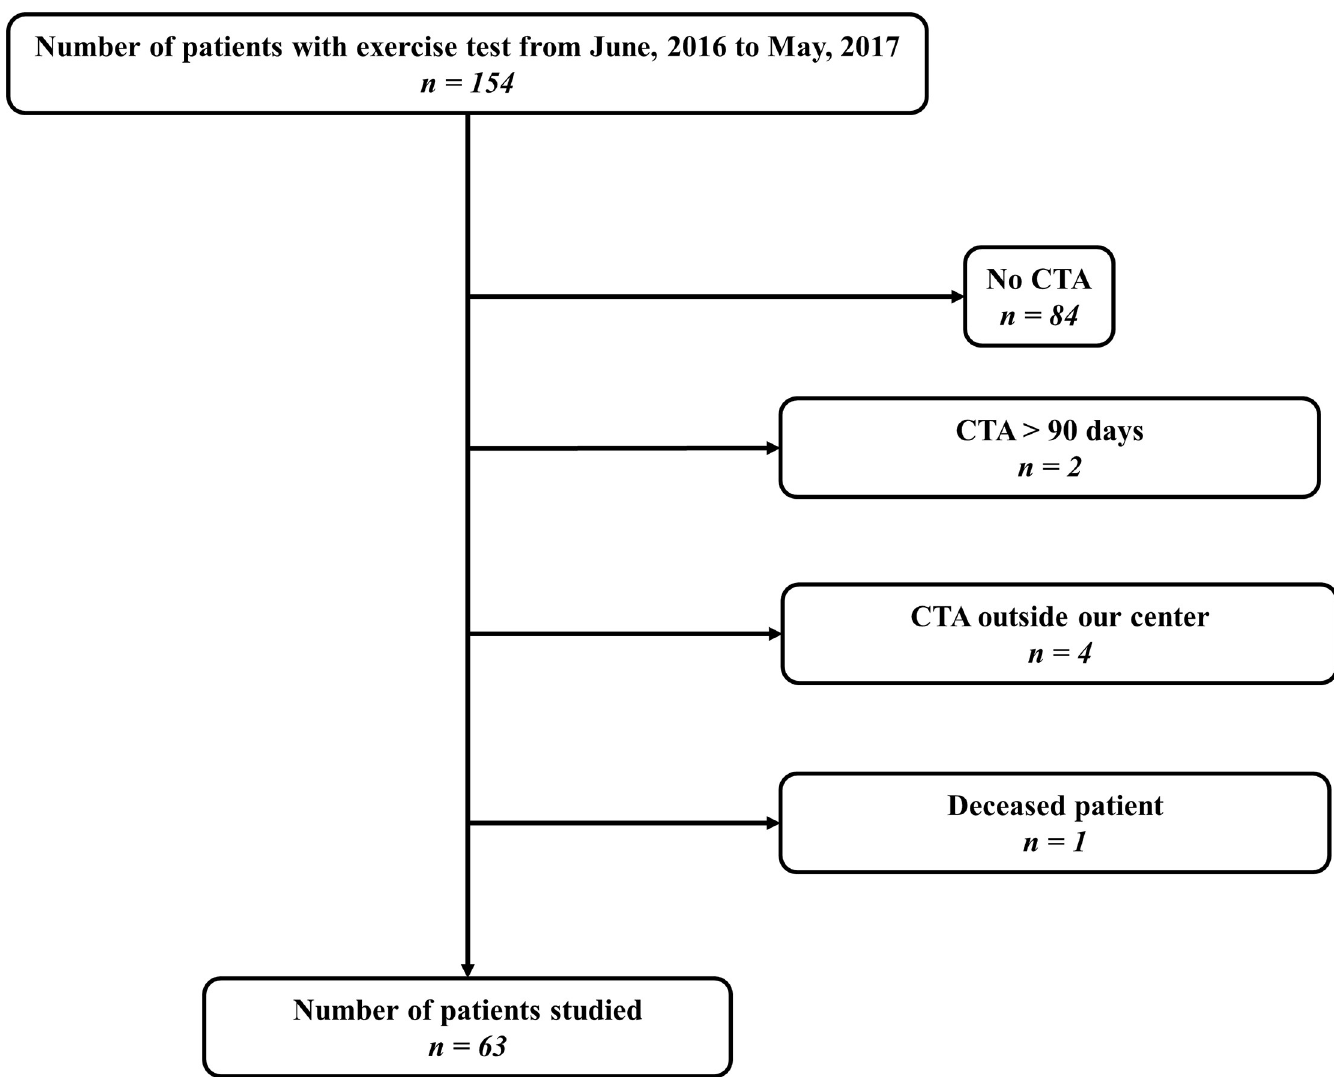
Fig 1. Flow chart. CTA, Computed tomography